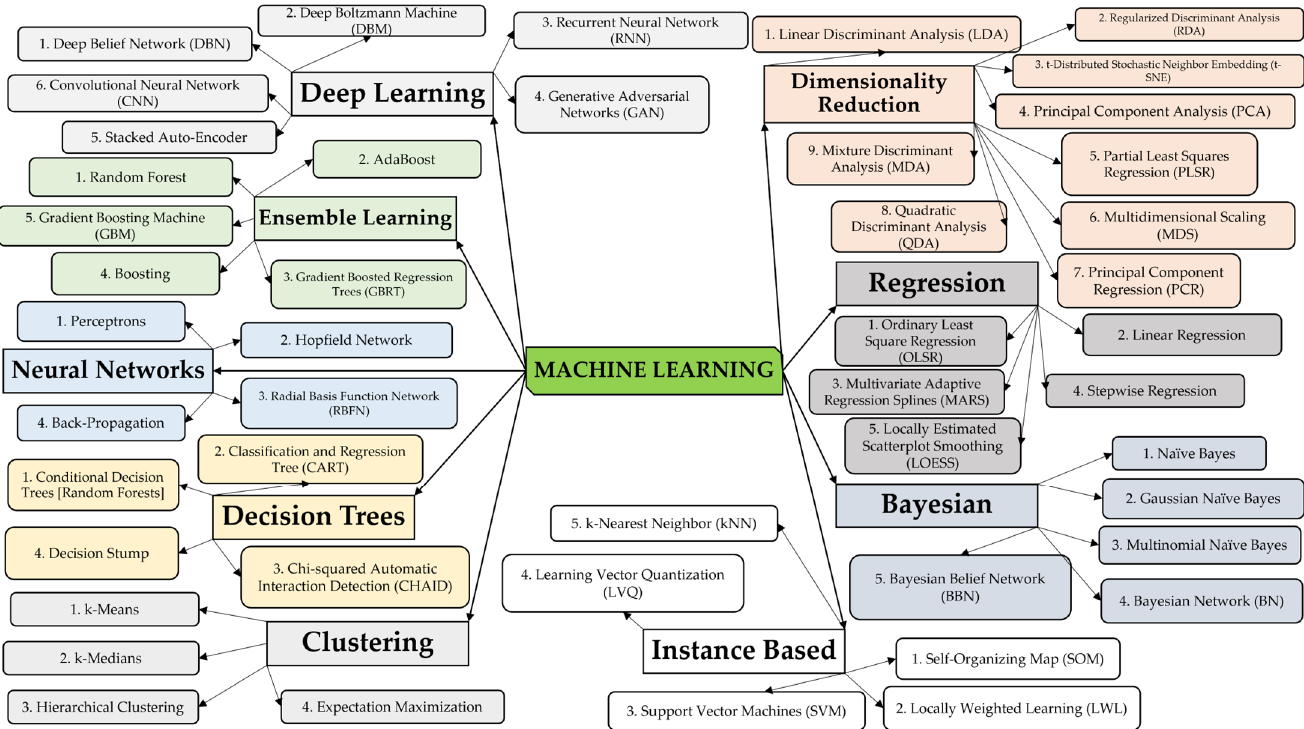
Figure 4. Concept map for machine learning applications on big data analysis in image-based SHM: